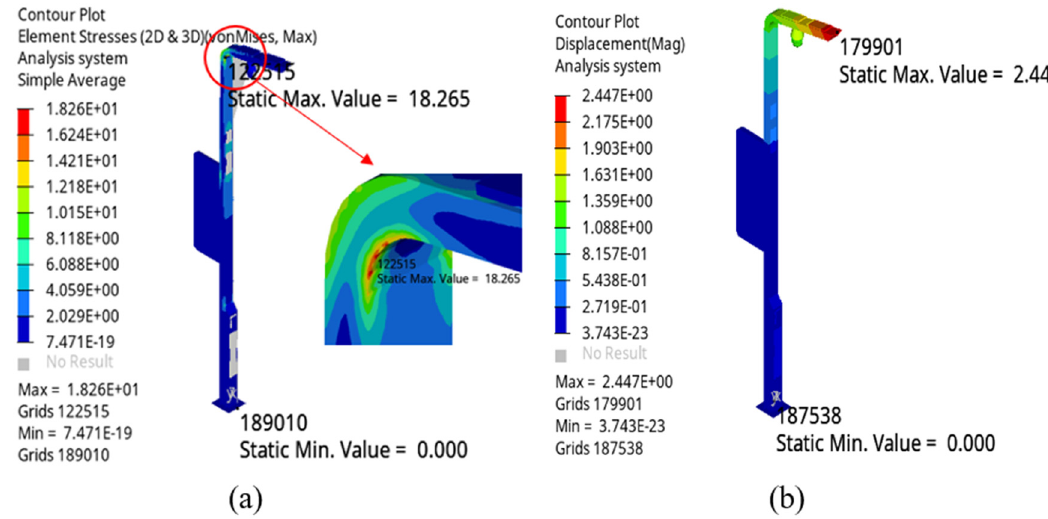
Figure 6: The cloud diagram under full load condition of snow: ( a ) stress and ( b ) displacement.